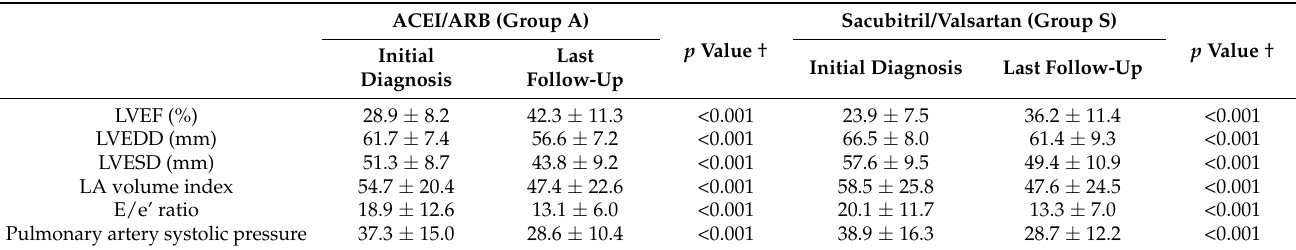
Table 3. Echocardiographic changes from the initial diagnosis to the last follow-up.